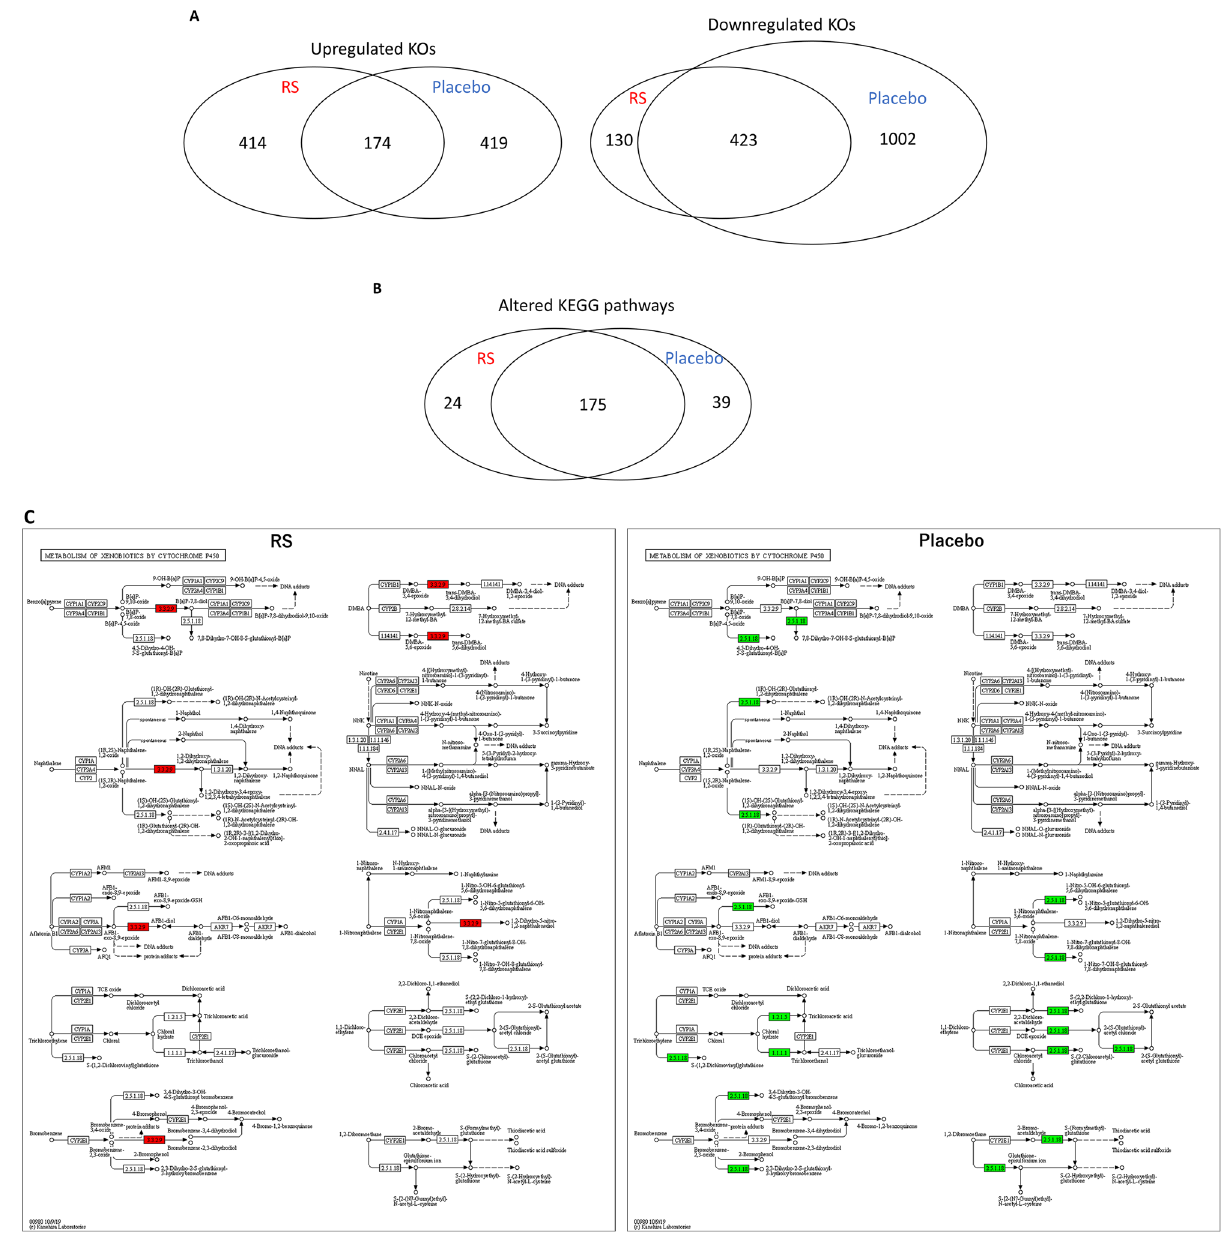
Figure 5. Alternation of microbial KEGG pathways in RS group. ( A ) Venn diagram analysis of altered KEGG orthologues (KOs) identified PICRUSt analysis. ( B ) Venn diagram analysis of KEGG pathways predicted by KEGG Mapper. ( C – E ) Several KEGG pathways were up-regulated in RS group compared with those of the placebo group. Metabolism of xenobiotics by cytochrome P450 ( C ), cationic anti-microbial peptide (CAMP) resistance ( D ), and nicotine and nicotiamide metabolism ( E ). Red and green indicates up-regulation and down- regulation,